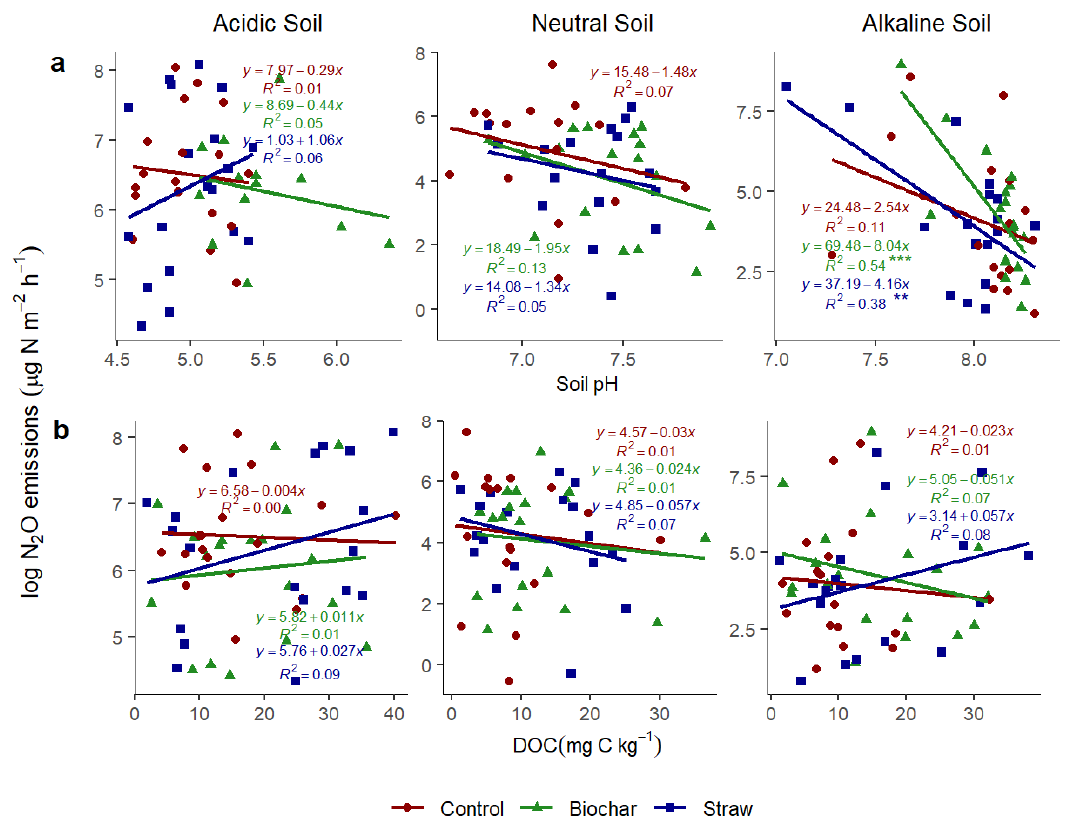
Figure 7. The relationships of N 2 O emissions and ( a ) soil pH and ( b ) DOC under different soil pH treated with biochar and straw averaged over 19 days. Note: (**) shows that the strength of the relationship is significant at p -value ≤ 0.01, and (***) shows that the strength of the relationship is significant at p -value ≤ 0.001. The axes of the different natural soil pH values are on different scales, and the log designation refers to natural logarithms.